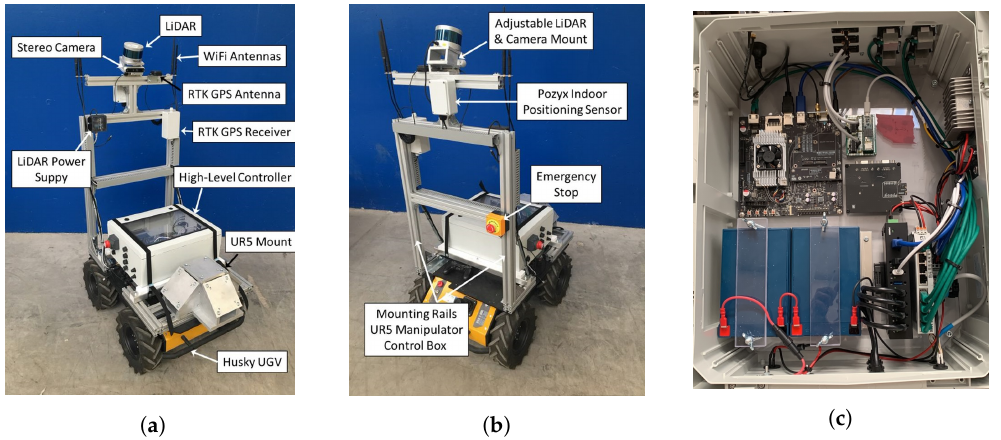
Figure 11. Mechanical and electronic configuration of the experimental platform (UR5 manipulator not shown): ( a ) front view, ( b ) back view, and ( c ) second control